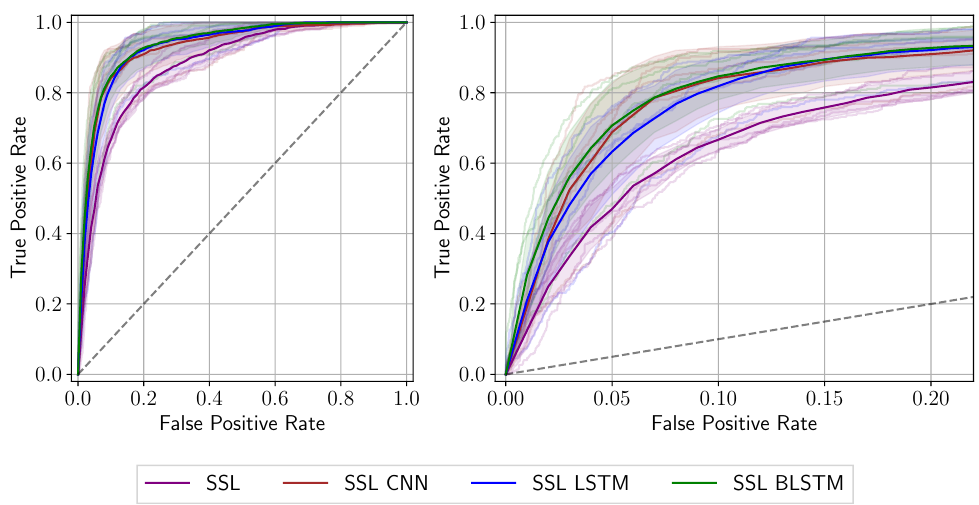
Figure 4. Receiver Operating Characteristic curve of the models studied. Each fold of the cross- validation split is shown in a softer version of its respective model color. The strong line represents the mean of those executions, while the background shade is the standard deviation. A magnified version is provided on the right.